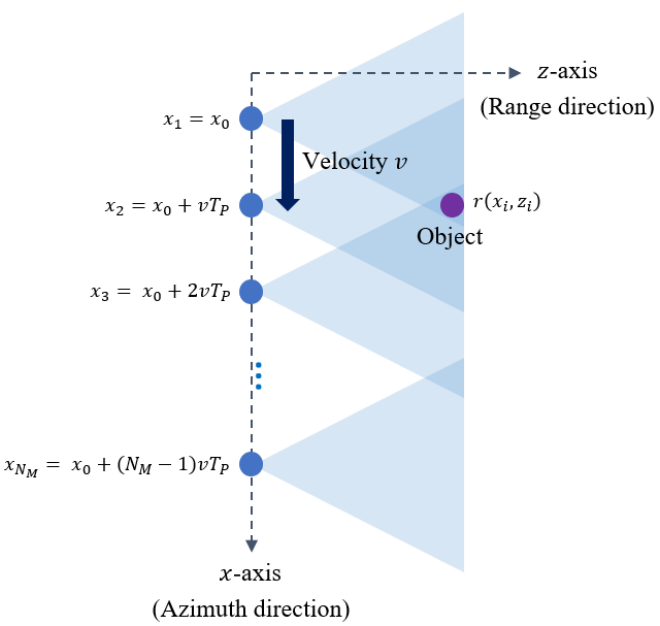
Figure 2. Movement of the SAR platform in the azimuth